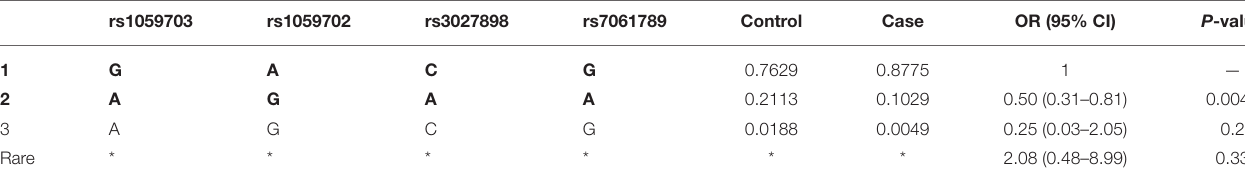
TABLE 6 | IRAK1 haplotype association with